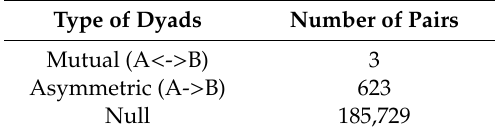
Table 5. Dyad census of a manure trade network in the three studied